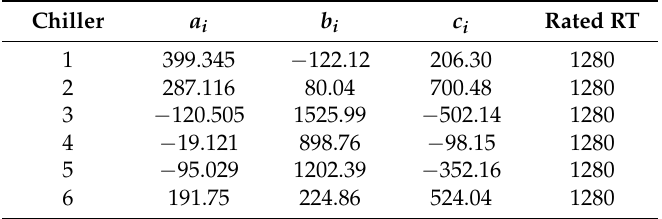
Table 1. Power consumption coefficient and rated RT information for case study 1.